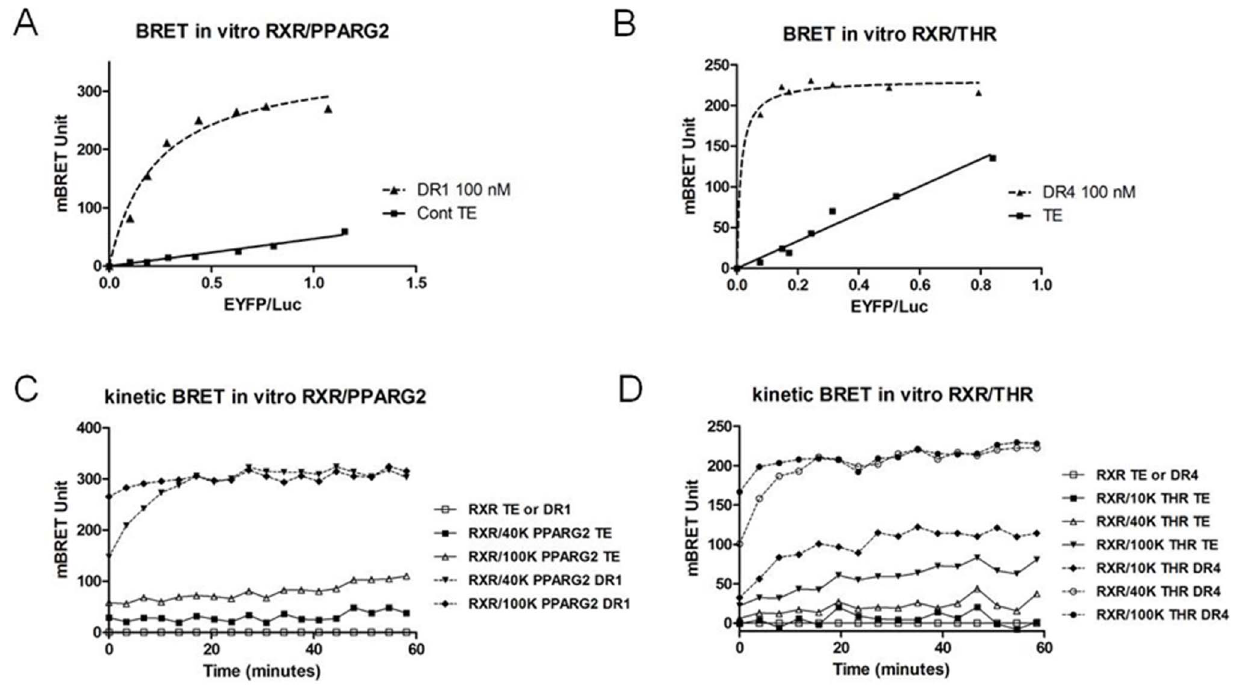
Figure 4. Invitro BRET shift between NRs in cleared cell lysates in the presence of a DNA RE. (A and B) For these in vitro titration BRET experiments, a fixed amount of PLB cell lysate expressing RXR-Luc protein (80 ku luciferase) is mixed with increasing amount of a PLB cell lysate expressing PPARG2-EYFP or THR-EYFP (0, 10, 20, 30, 50, 75, 100 or 150 ku of fluorescence) and regression curves are represented as the BRET value (recorded over a 20 min period) as a function of the fluorescence/luminescence ratio in the absence (control TE: Tris 10 mM PH 7,5; EDTA 1 mM) or presence of 100 nM of dsDNA RE (diluted in TE). (A) In vitro BRET saturation between RXR-Luc and PPARG2-EYFP with TE (control TE, filled squares) or 100 nM of dsDNA DR1 (filled triangles). (B) In vitro BRET saturation between RXR-Luc and THR-EYFP with TE (control TE, filled squares) or 100 nM of dsDNA DR4 (filled triangles). (C) One hour BRET kinetic monitoring in vitro interaction between 80 ku of donor RXR-Luc and 40 ku or 100 ku fluorescence of PPARG2-EYFP in the absence (control TE) or presence of 100 nM of dsDNA RE DR1. (D) One hour BRET kinetic monitoring in vitro interaction between 80 ku of donor RXR-Luc and 10 ku, 40 ku or 100 ku fluo of THR-EYFP in the absence (control TE) or presence of 100 nM of dsDNA RE